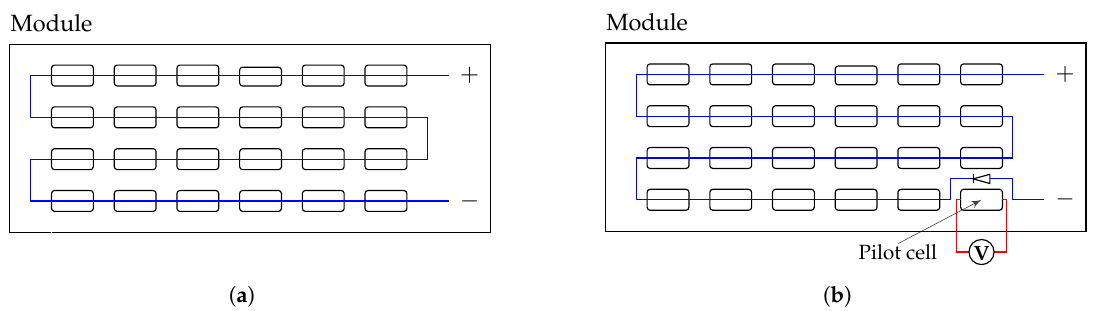
Figure 4. PV panel configuration during one measurement cycle. ( a ) First stage: all N cells provide power to the load, semi-pilot cell is connected to the array; ( b ) Second stage: semi-pilot cell is disconnected from the array.